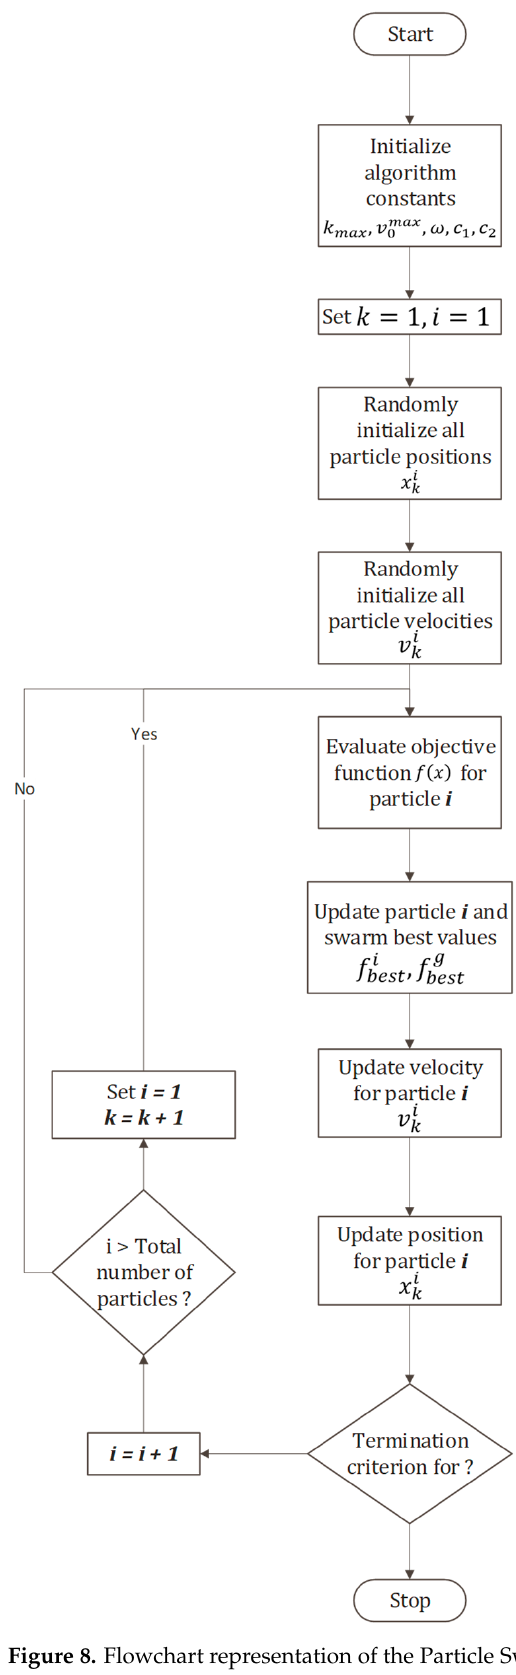
Figure 8. Flowchart representation of the Particle Swarm Optimization method. Amongst the influencing parameters on the performance of PSO algorithm, inertia weight plays a significant role, reminiscent of the temperature parameter in Simulated Annealing (SA). This value determines the ability of PSO in both global and local search levels, and should be adjusted to balance both local and global exploration ability of PSO. Inertia weight value identifies the suitability of a suggested PSO for global or local optimizations. While the global search requires a higher value of inertia weight, the local